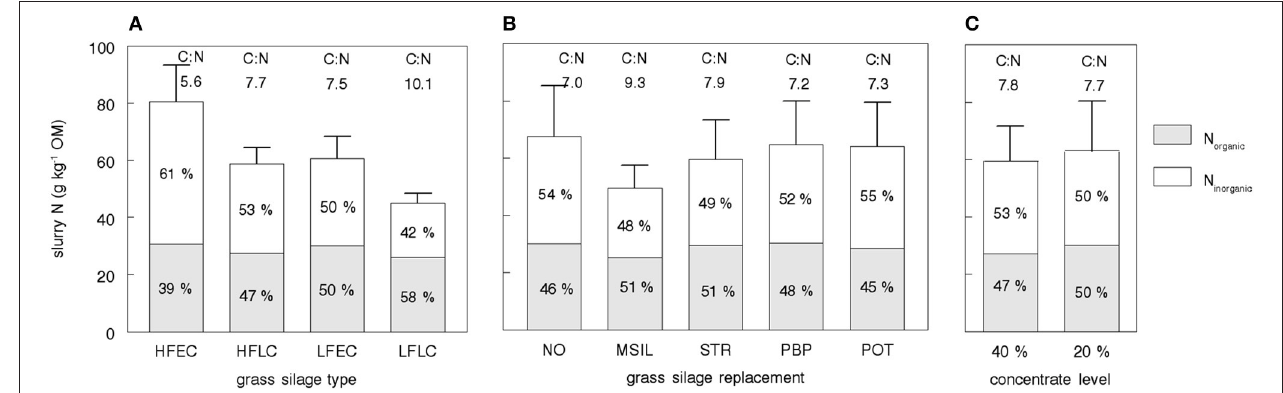
FIGURE 4 | Simulated total, organic and inorganic slurry nitrogen (N) content after 4 months of storage and the simulated slurry carbon (C) to nitrogen (N) (C:N total ) ratio as affected by nutritional strategy. The bars represent average values for all strategies with a given grass silage type ( A , n = 10), grass silage replacement ( B , n = 8), and concentrate level ( C , n = 20) as described in Table 3 . HFEC, high fertilized, early cutting stage grass silage; HFLC, high fertilized, late cutting stage grass silage; LFEC, low fertilized, early cutting stage grass silage; LFLC, low fertilized, late cutting stage grass silage; NO, no replacement of grass silage; MSIL, maize silage; STR, straw; PBP, pressed beet pulp; POT, potatoes.